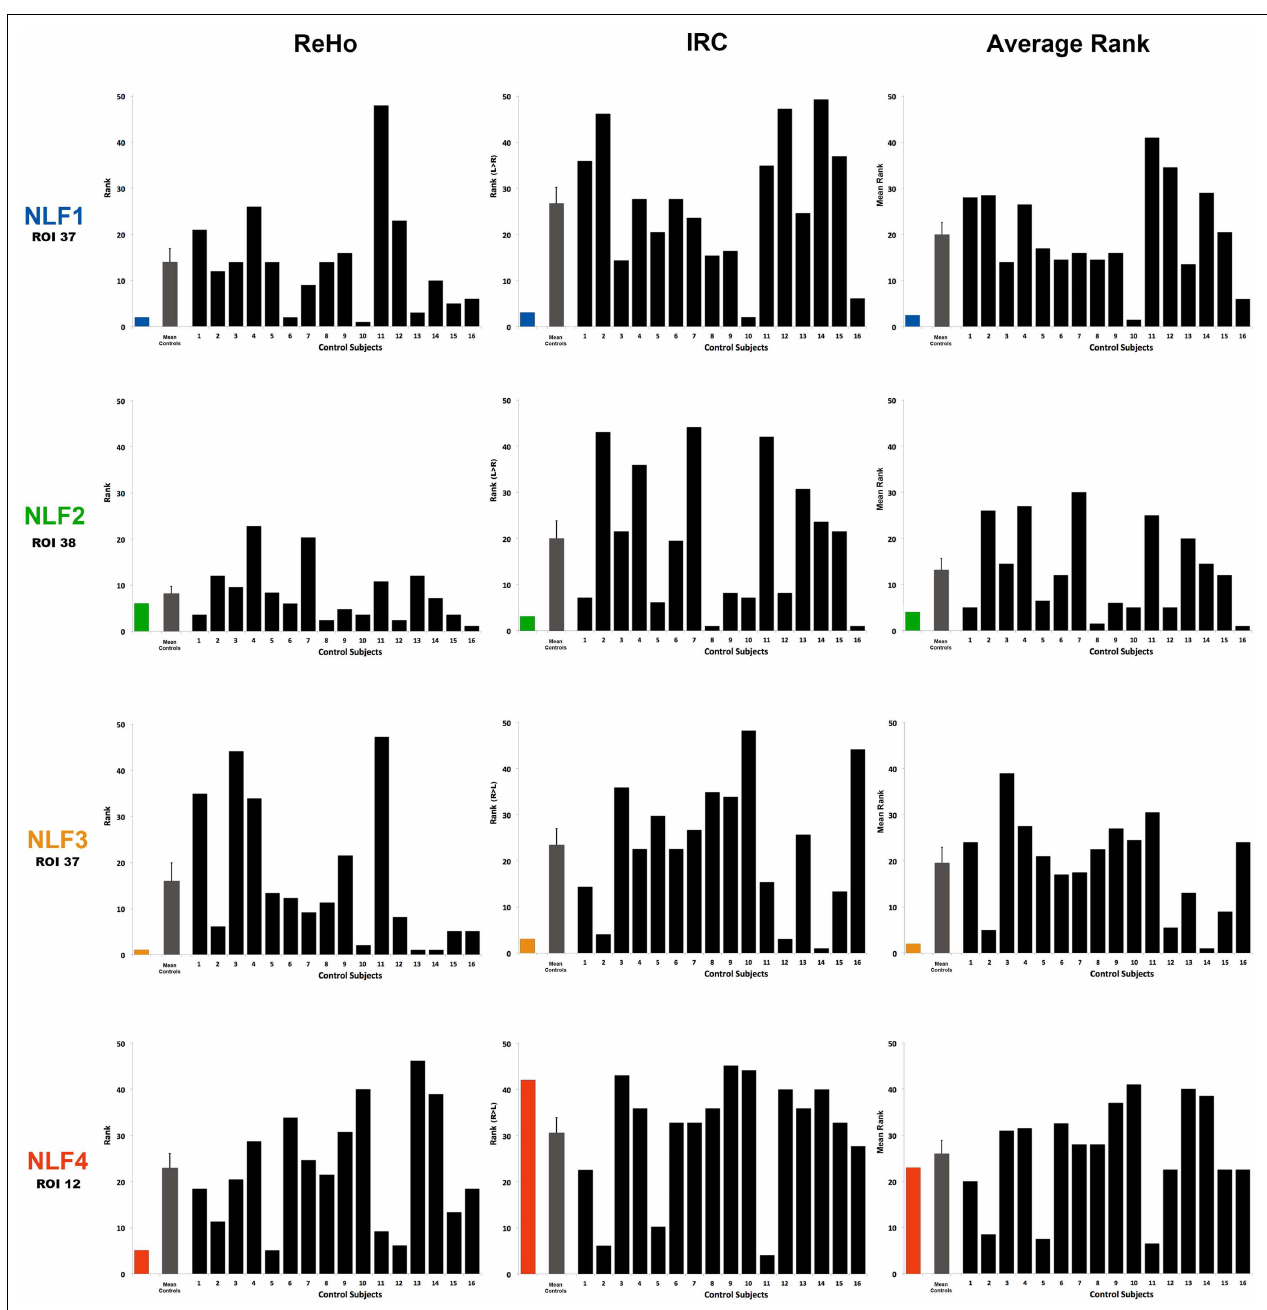
column plots the IRC ranks (ranking either R > L or L > R) and the third the average rank across the two methods for all subjects.The color bar represents the ranking for the respective NLF subject as noted in Table 1 . The gray bar represents the mean (with standard error of the mean) of the 16 controls subjects, and each black bar represents the ranking for each control